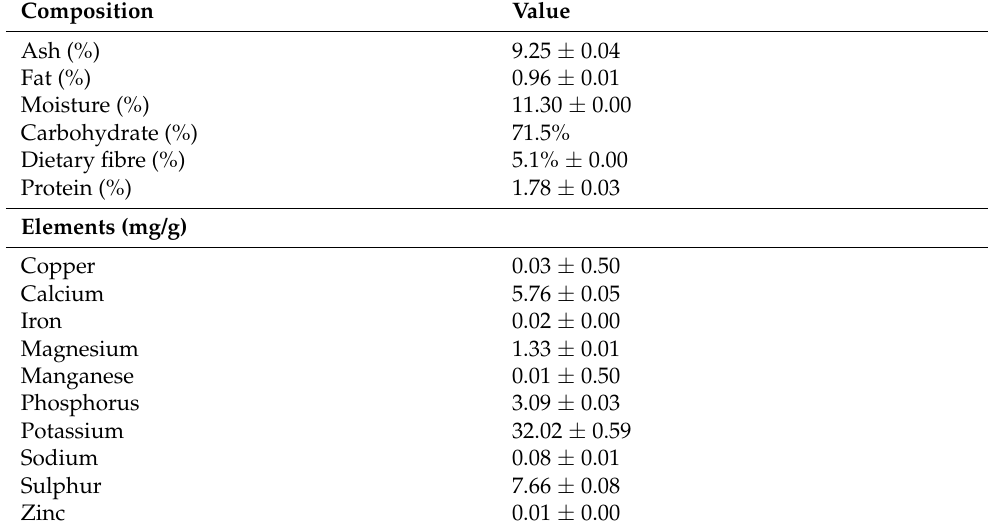
Table 1. Composition of nutrients in hydroponic wasabi ( Eutrema japonicum ) rhizome and stem blend